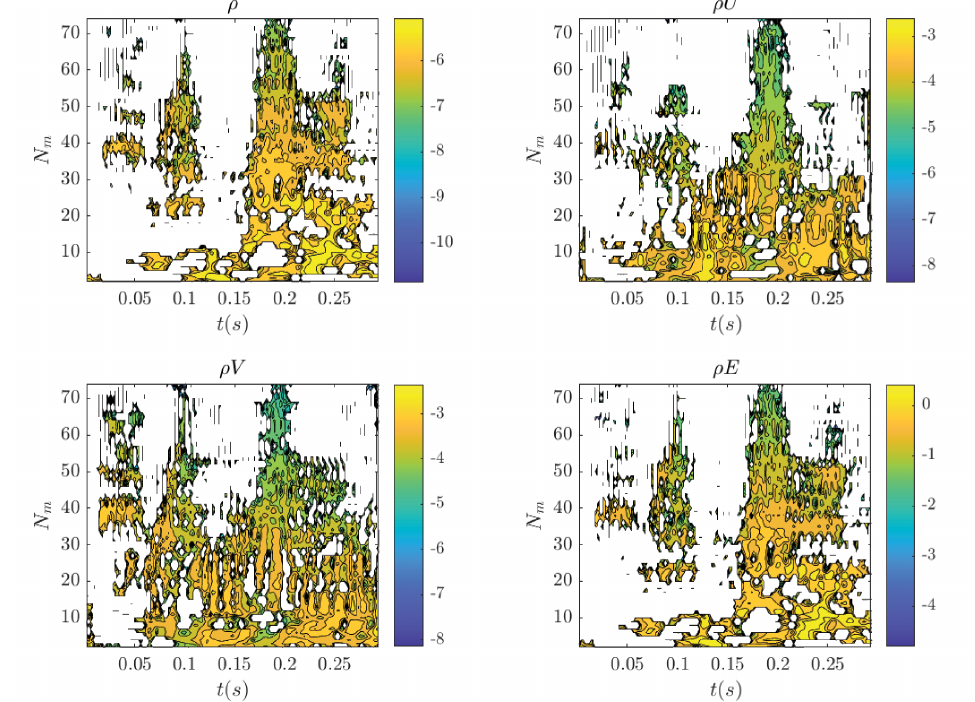
Figure 4. The log 10 ( (cid:101) diff ) considering POD as the reference single ROM, versus the time and number of modes, NACA0009 test case. White regions correspond to (cid:101) diff = 0, i.e., the residual based adaptive ROM selects